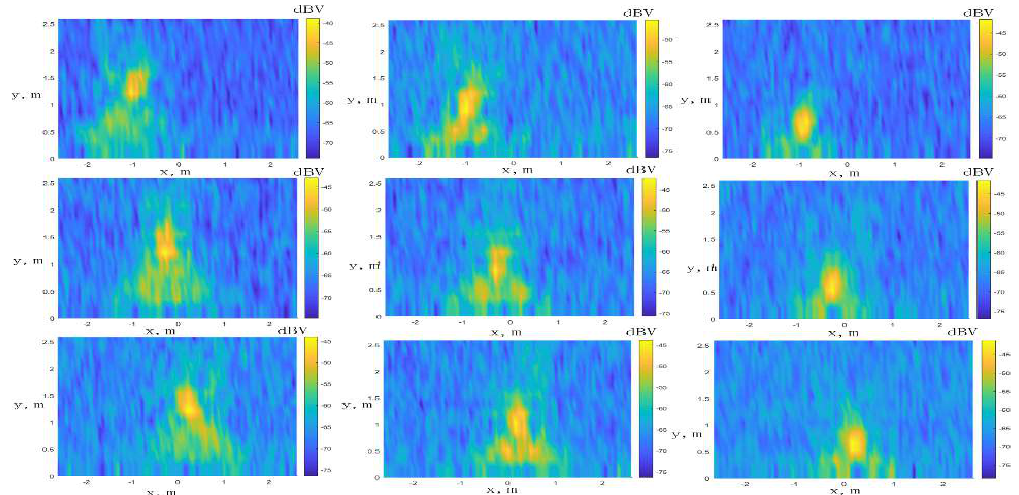
Figure 13. The electric field values vary as the locations of sources at 4 GHz.